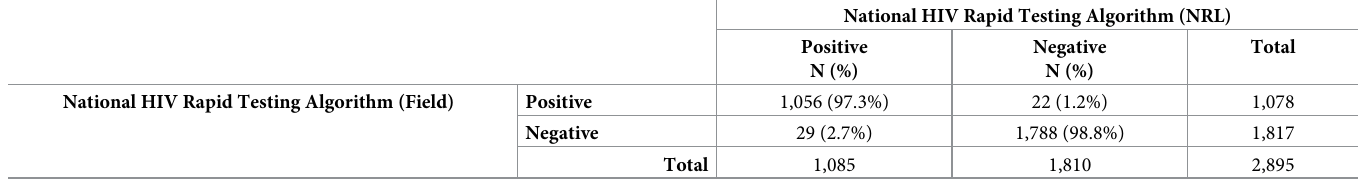
Table 3. Summary of the national serial HIV rapid testing algorithm performed in the field compared with the re-testing at the NRL from the prospective